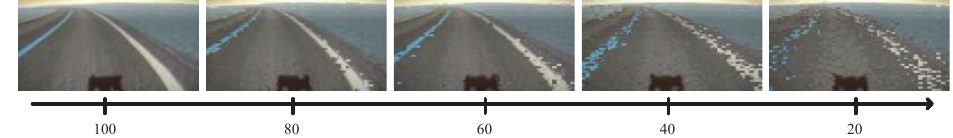
Figure 2. Effects of resource restriction: Observation examples in the case of Figure 1a where the numbers on the line denote the resource